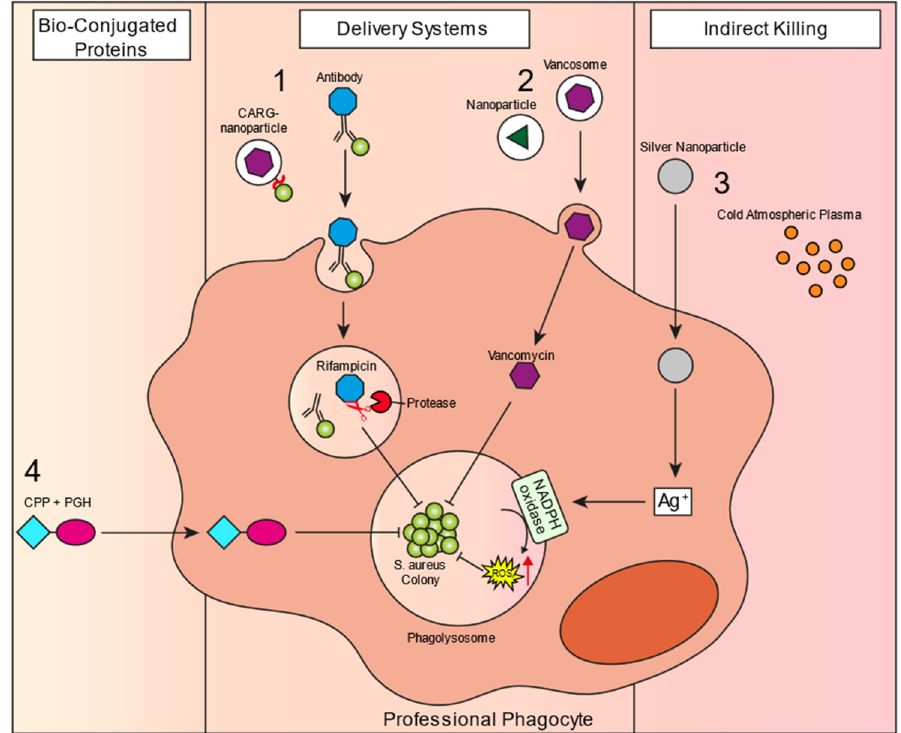
Figure 3. Novel treatment strategies to reach the intracellular reservoir of S. aureus . Schematic of different therapeutics that can penetrate host cells. 1. S. aureus -targeted delivery: antibody conjugated to antibiotic—a specific S. aureus antibody binds extracellular bacteria and is taken up into the phagolysosome with the bacteria. Inside the phagolysosome, host-derived proteases can cleave off the rifalogue conjugated to the antibody, activating it, which can then attack the intracellular bacteria; CARG-nanoparticles—a specific peptide based on phage-displayed peptide libraries conjugated to vancomycin ‐ containing nanoparticles. Similar to the antibody approach, it targets S. aureus and can reach the intracellular reservoir. 2. Nanoparticle/liposome delivery system: antibiotics can be taken up inside nanoparticles or liposomes, which can fuse with the cellular membrane to deliver the encapsulated drug intracellularly. 3. Indirect killing: silver nanoparticles deliver silver into the host cell cytoplasm, which in turn activates NADPH oxidase to induce ROS production, leading to improved killing of the intracellular reservoir. Cold atmospheric plasma can directly act upon NADPH oxidase to stimulate ROS production. 4. Bio ‐ conjugated proteins: cell penetrating peptides (CPPs) are molecules that can penetrate the host cell to deliver the attached peptidoglycan hydrolase (PGH).